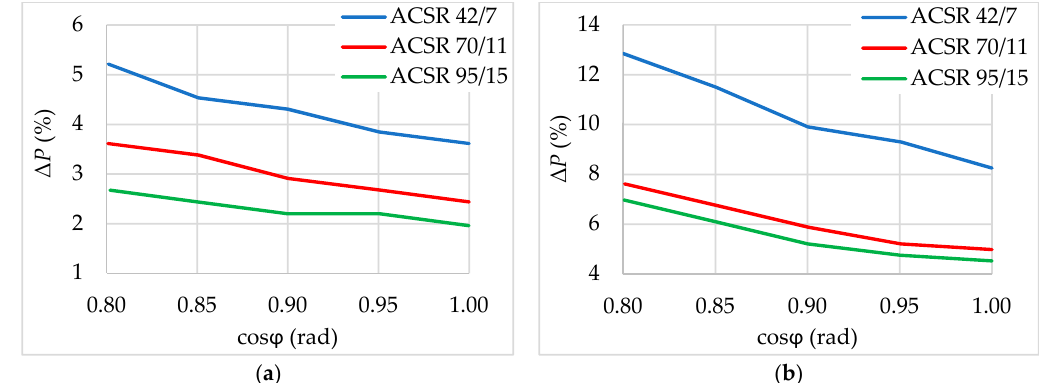
Figure 19. The graphic dependence of increasing APLs from power factor (PF): ( a ) the length of 20 km;